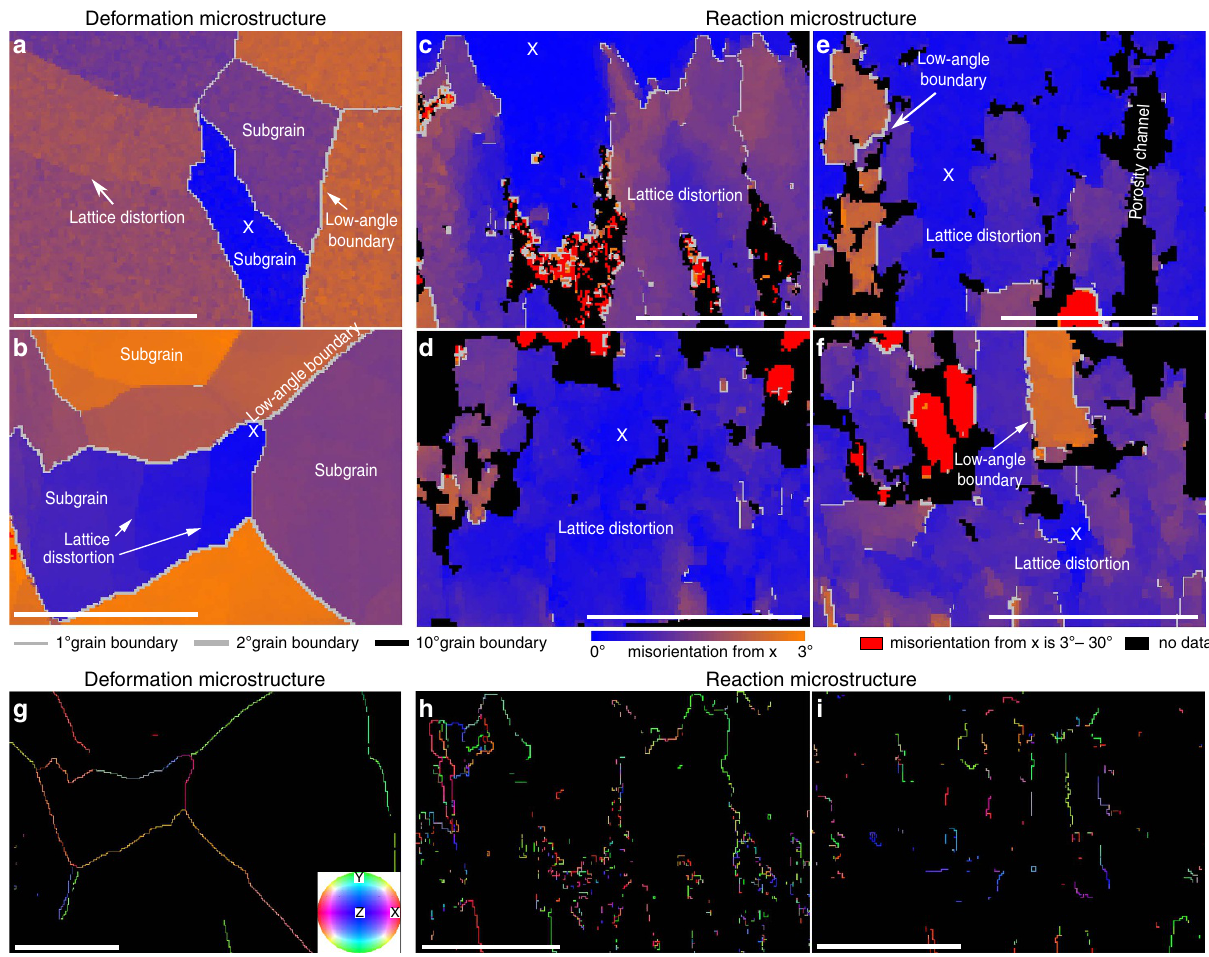
Figure 5 | Higher-magnification images of deformation and reaction microstructures. The scale bar on all images is 200 m m. ( a , b ) Deformation microstructure in Fig. 3d,e, respectively. ( c – f ) Reaction-generated microstructure in Fig. 3a,c,f. Note that the colour scale represents smaller range in misorientation angles compared with Fig. 3 in order to better show structural heterogeneity. ( g – i ) Misorientation axes of low-angle boundaries ( 4 1 (cid:2)